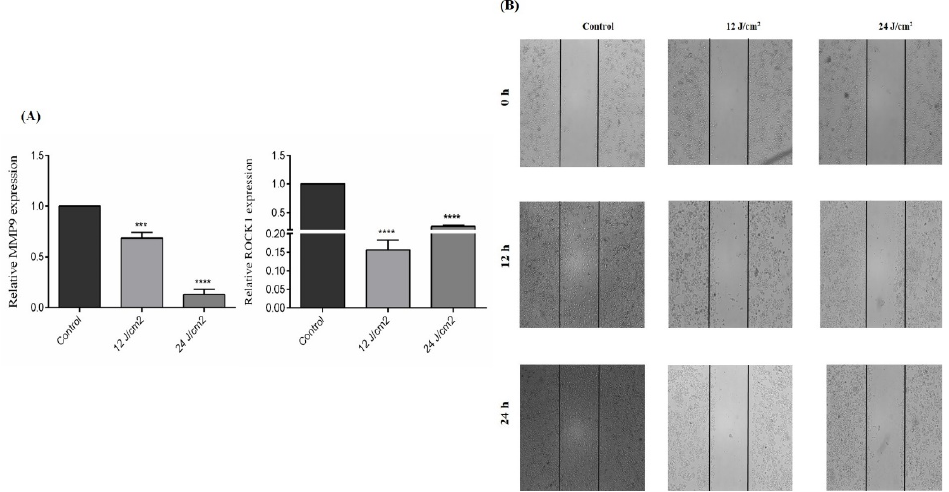
Figure 7. The effect of ZnPc-PDT on the migration of SW480 cells. ( A ) The effect of ZnPc-PDT on MMP9 and ROCK1 gene expression. Results are presented as means ± SD of 3 independent tests and, *** p < 0.001, **** p < 0.0001 versus control. ( B ) After ZnPc-PDT, wound gaps were studied at 0 h, 12 h, and 24 h.